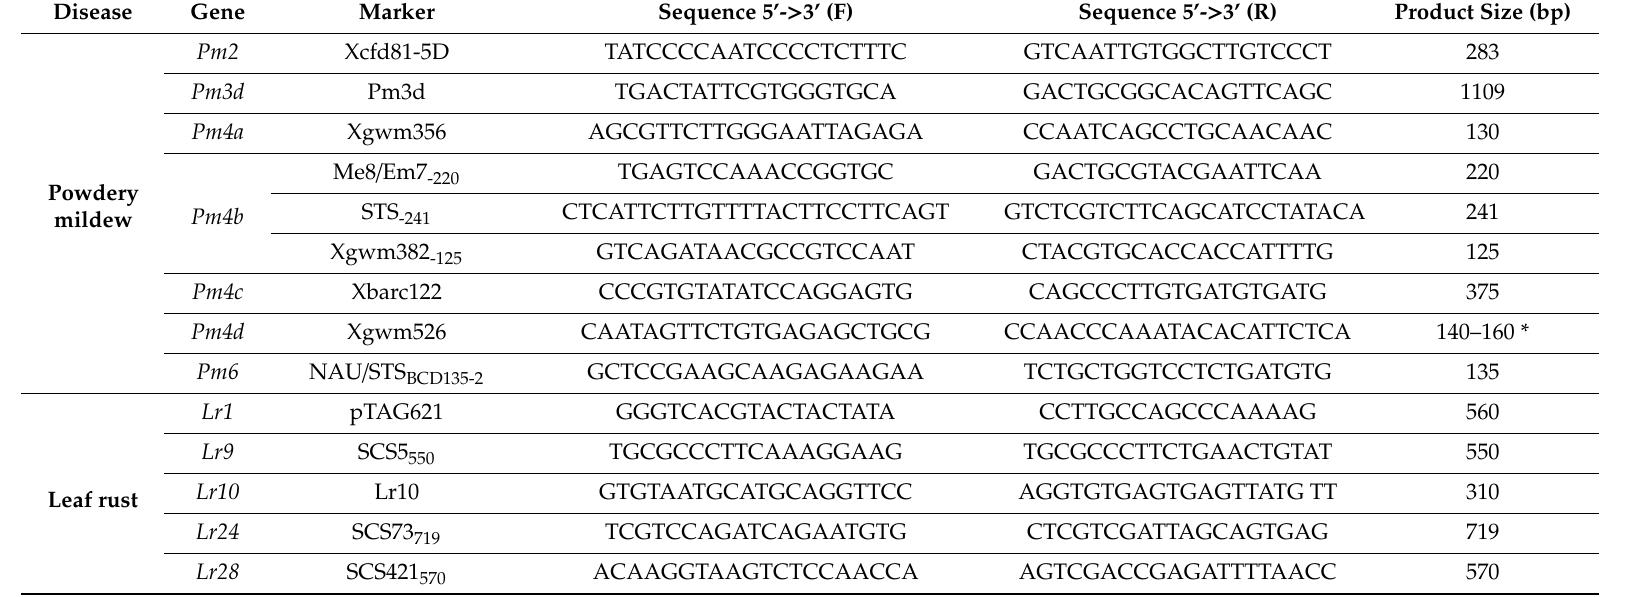
Table 2. Primer sequences for DNA markers linked to powdery mildew and leaf rust resistance genes in